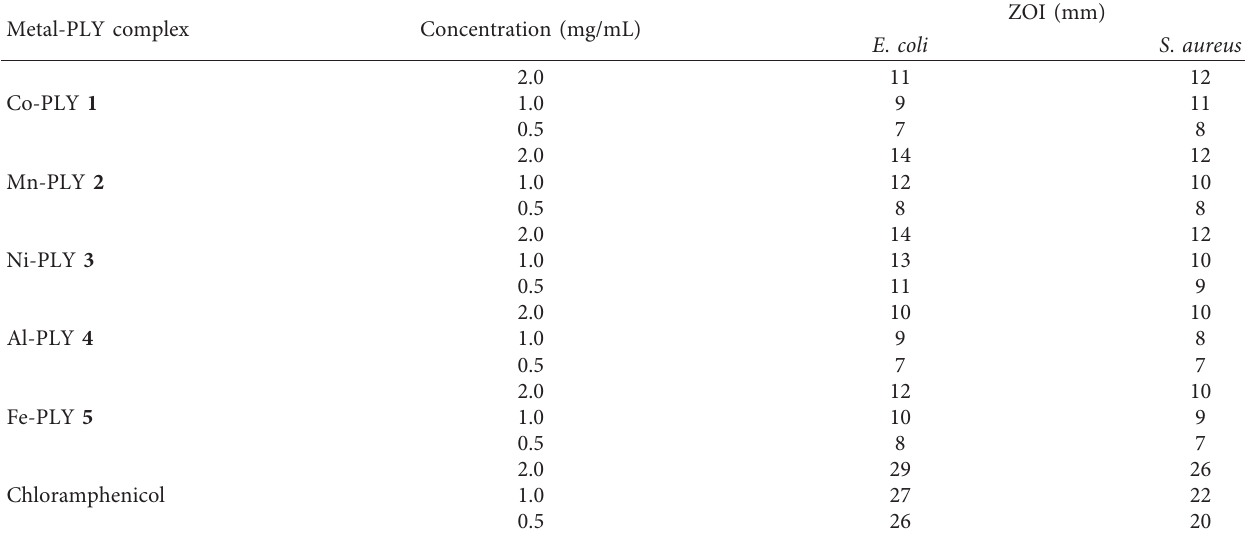
Table 2: ZOI values against E. coli and S. aureus of various metal-PLY complexes (1 – 5) and positive control chloramphenicol at different